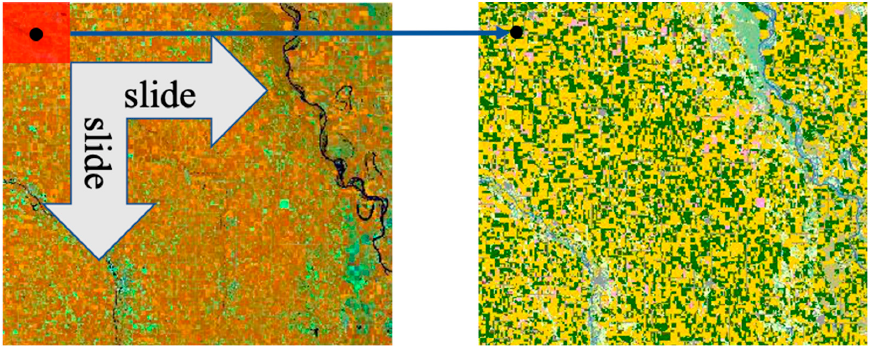
Figure 3. Example of making a training sample pair. The fixed-size window is slidingly cut on the input remote sensing image, and the crop type label corresponding to each remote sensing image is the crop with the center point at the corresponding position of the CDL image. Figure 4 shows part of the training data produced from the combined data of bands 4, 3, and 2 on August 7. Our task was to classify the central pixels, and the remaining pixels in the image served as auxiliary information to help complete the classification task.